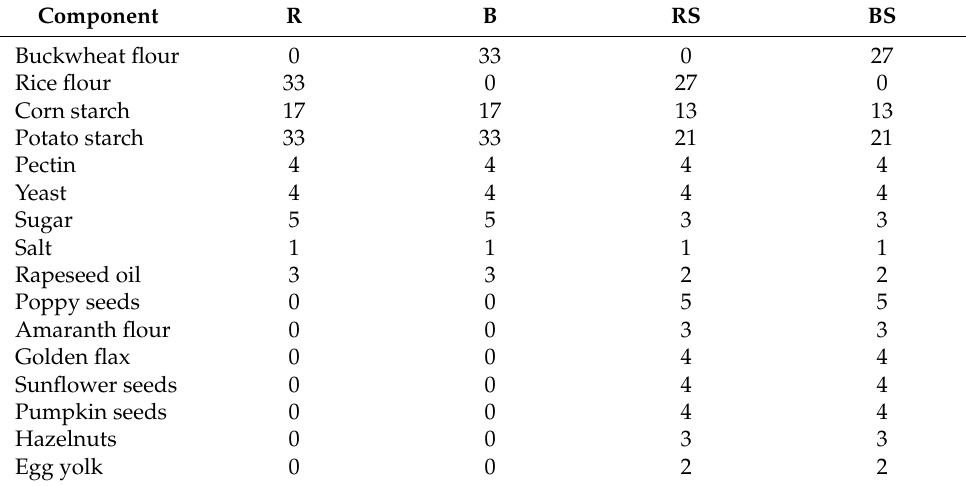
Table 3. Composition of breads (g/100 g).